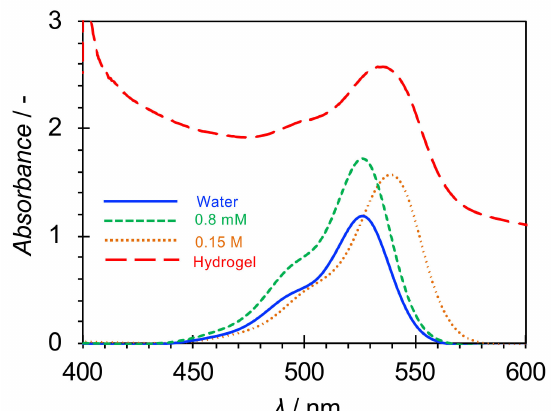
Figure 3. Absorption spectra of Rhodamine 6G in water (1.3 × 10 − 5 M), aqueous surfactant solutions [8 × 10 − 4 and 0.15 M; below and above the critical micellar concentration (CMC), respectively], and hydrogels [hexadecyltrimethylammonium bromide (CTAB); 0.15 M; 12-hydroxyoctadecanoic acid concentration C 12-HOA = 1.0 wt.%] at 25 ◦ C. Table 2. Critical micellar concentration (CMC) and counterion dissociation degree ( α ). CMC / mM α / -